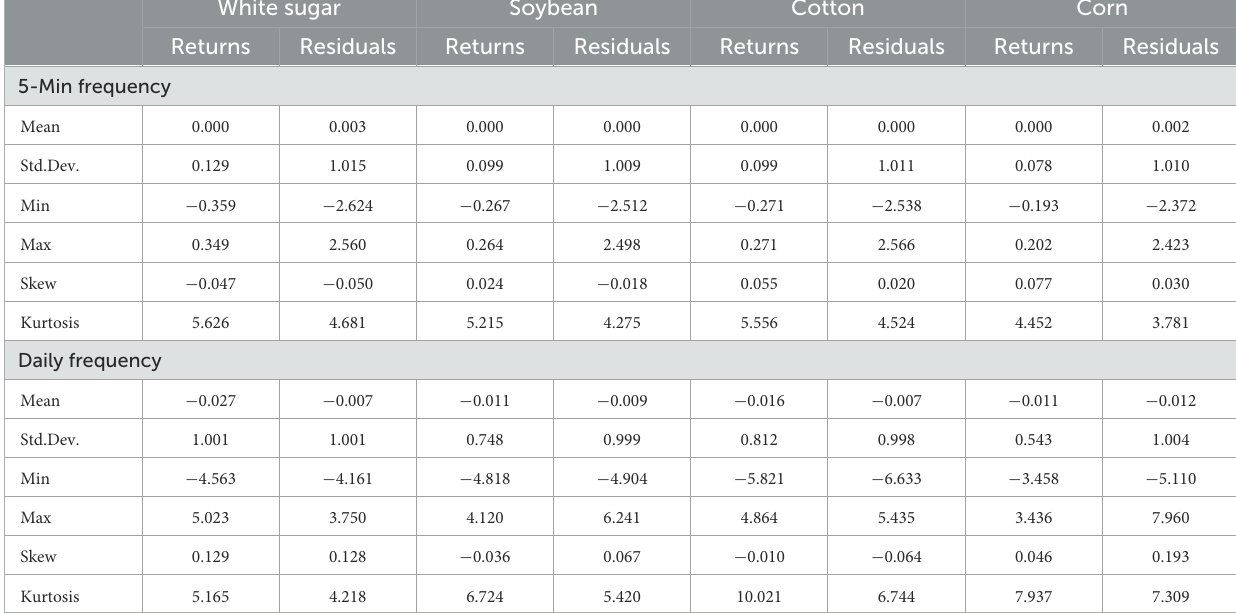
TABLE 2 Descriptive